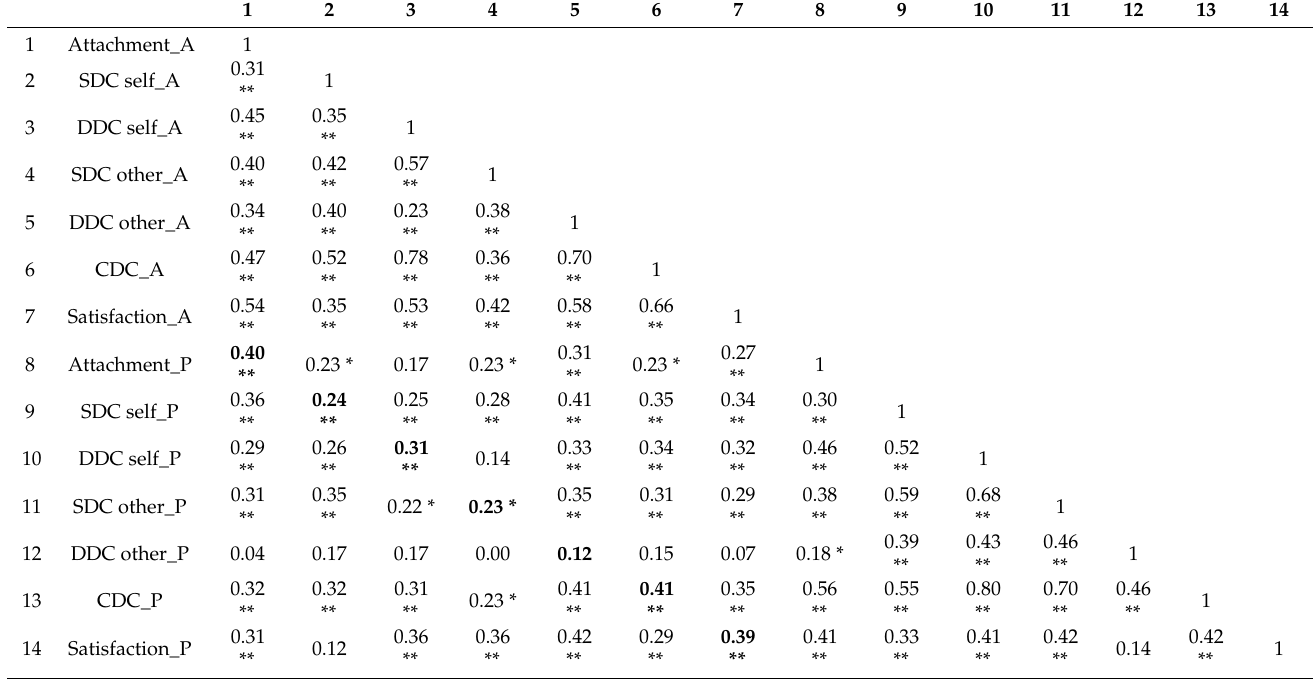
Table 3. Intercorrelations between the variables for women (_A) and men